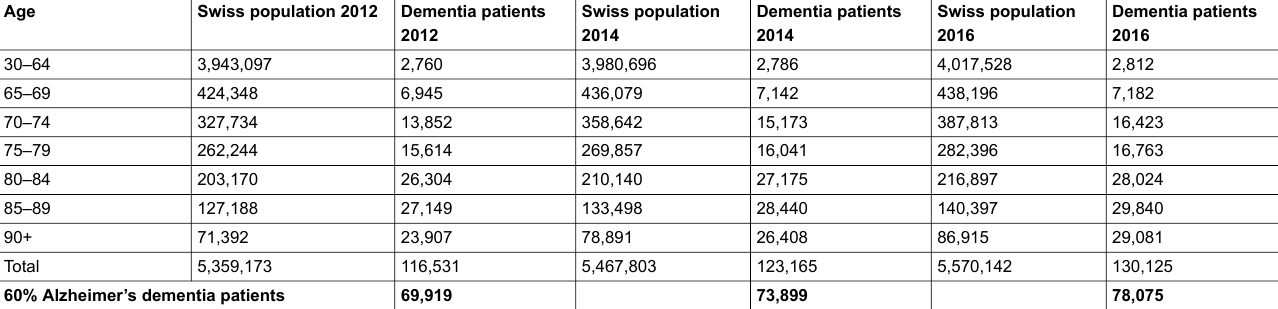
Table 3: Calculated prevalence of dementia and Alzheimer’s dementia in Switzerland for the years 2012, 2014, and 2016. Age